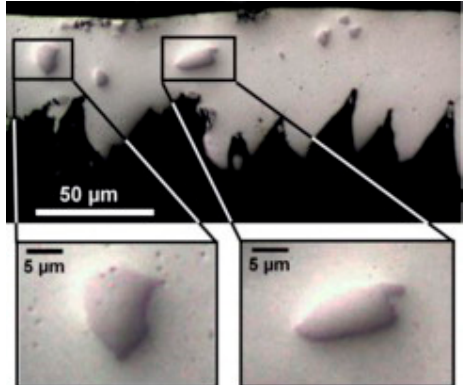
Figure 1. Unbroken particles at surface temperature 1000 °C and v c = 100 m/min with laser-assisted machining [9].